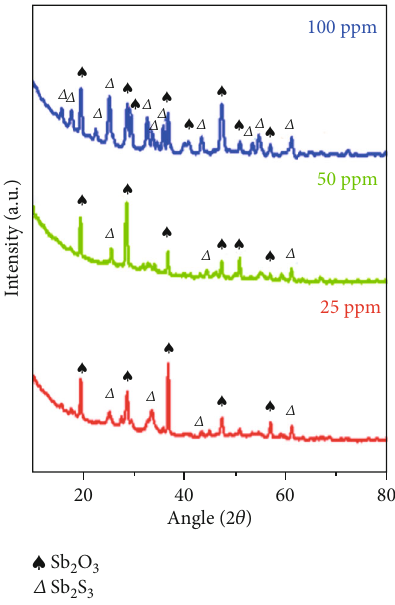
Angle (2 𝜃 ) ♠ Sb 2 O 3 𝛥 Sb 2 S 3 Figure 2: XRD patterns of the precipitates prepared in the presence of Gelatin at 25, 50, and 100